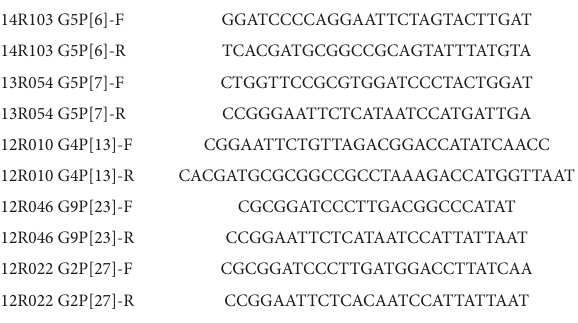
TABLE 1 Primer sequences for VP8 ∗